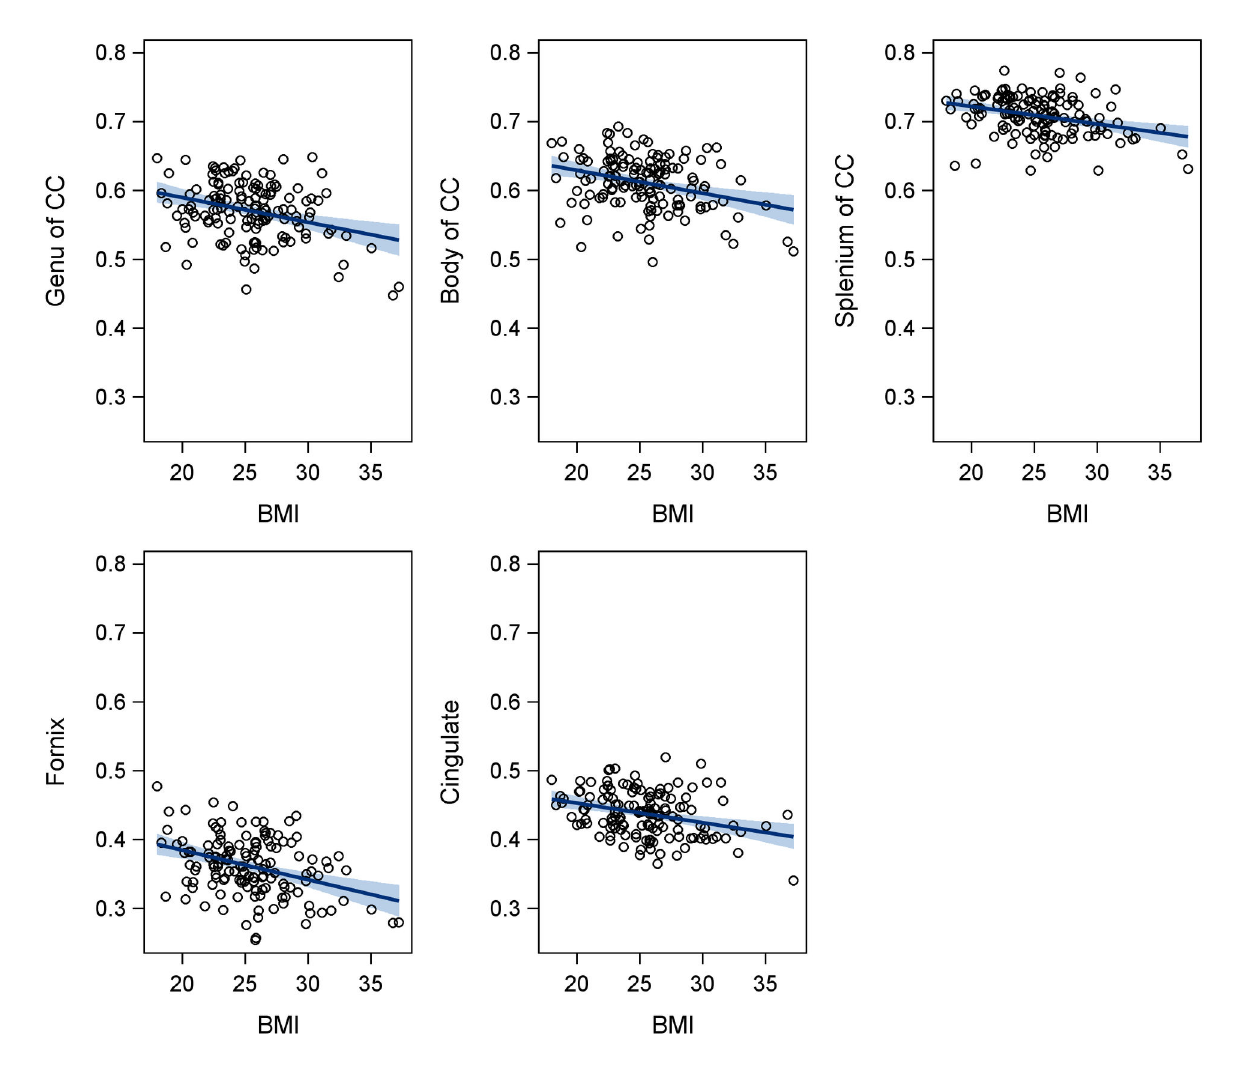
Figure 1. Displays the unadjusted relationship between BMI and fractional anisotropy (FA) of the corpus callosum genu, body, and splenium (top row), and FA of the cingulum and fornix (bottom row), with regression lines. Shaded areas represent 95% confidence intervals. All correlations displayed are significant at p <.05.